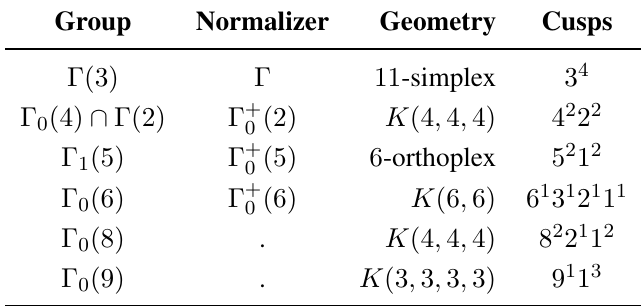
Table 1. Characteristics of torsion-free, genus zero, index 12 congruence